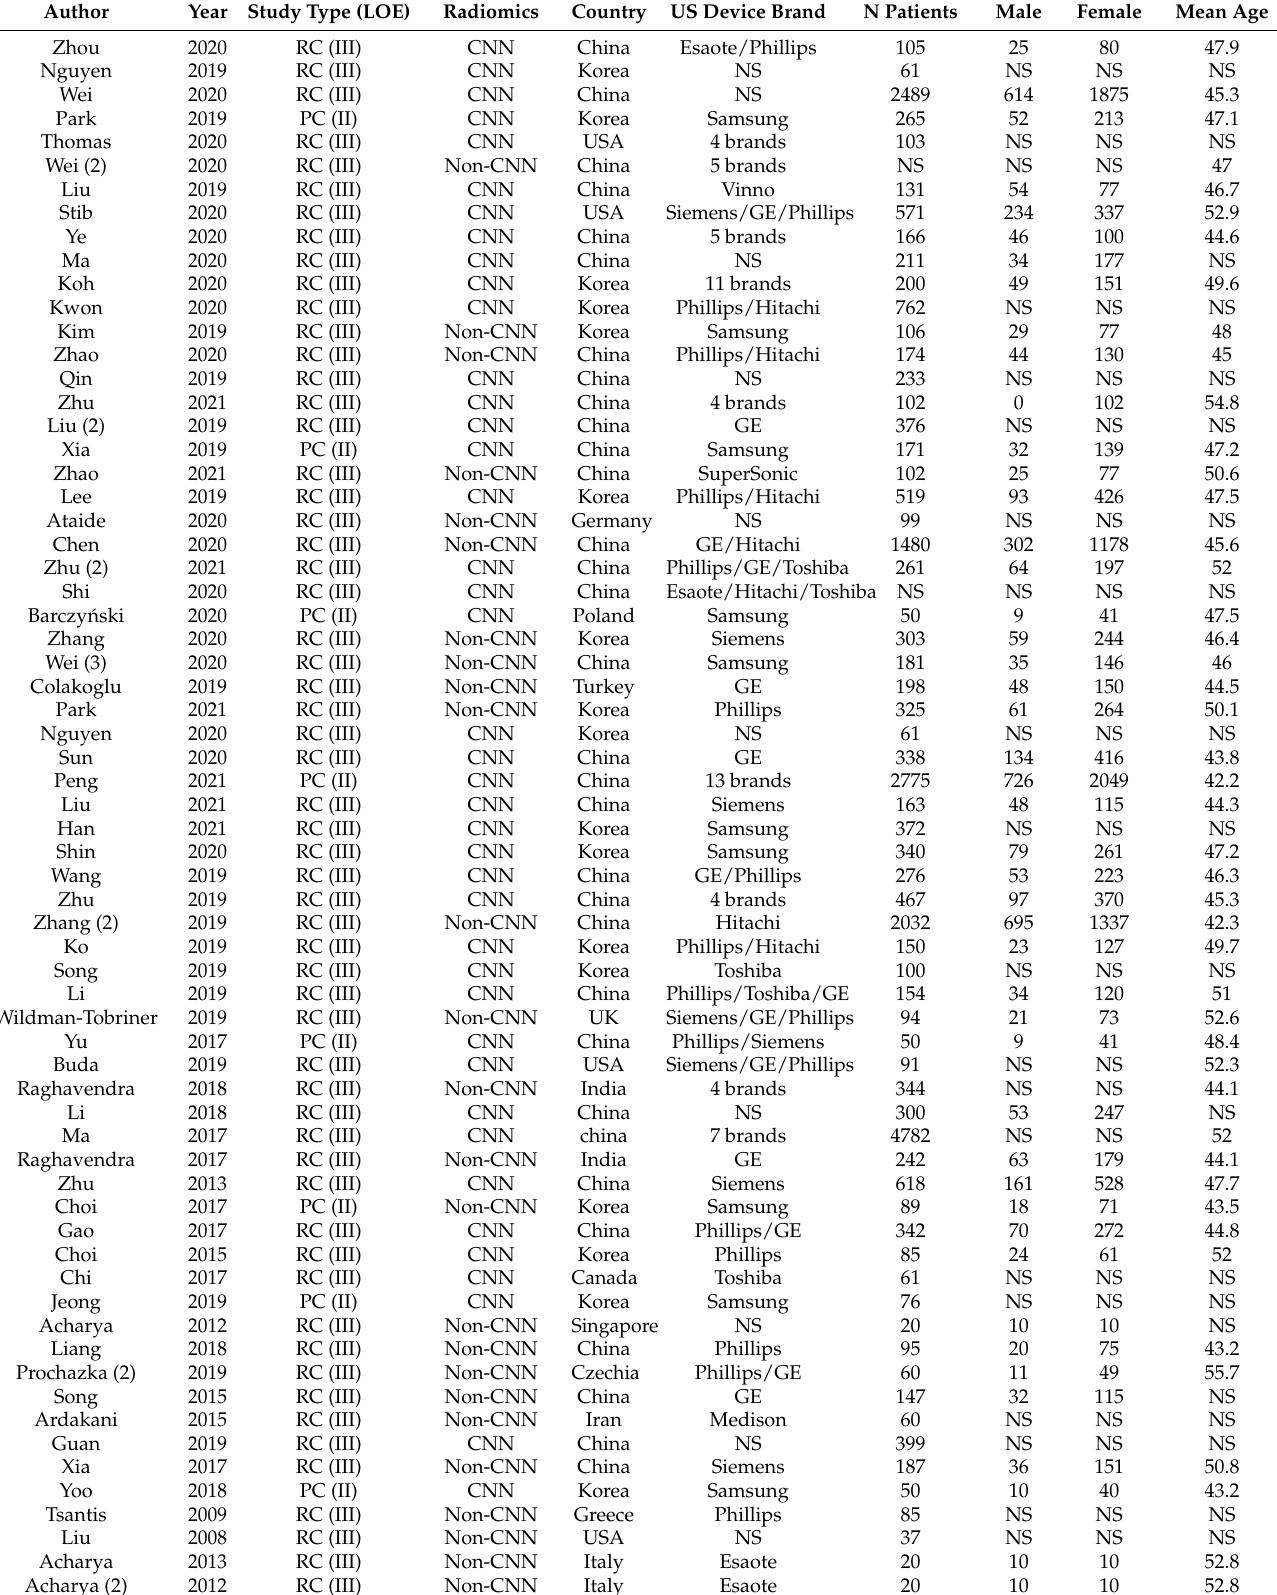
Table 1. Study characteristics and